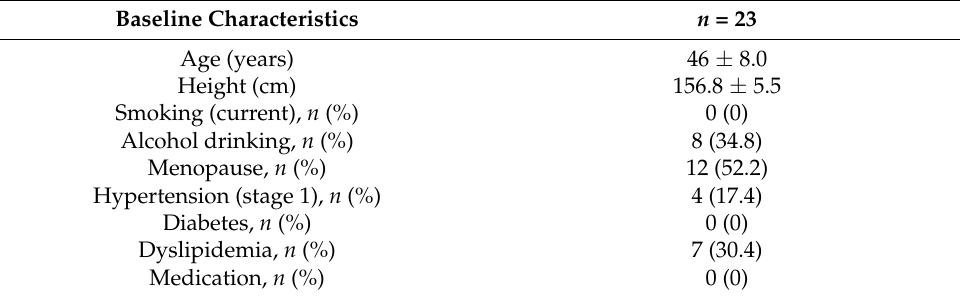
Table 1. Baseline clinical characteristics of